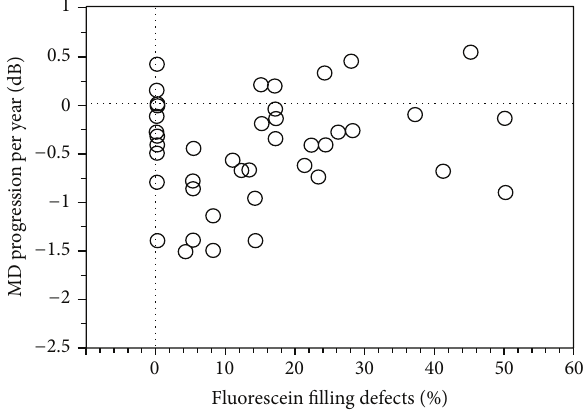
Figure 1: Bivariate plot of fluorescein filling defects ( 𝑃 = 0.37 , 𝑟 = −0.14 ) as a function of MD progression per year in patients with NTG.